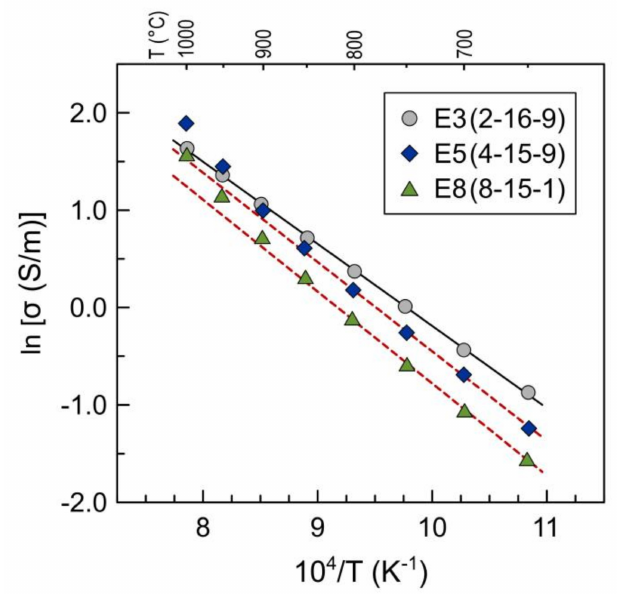
Figure 9. Temperature dependence of electrical conductivity of samples E3 (2-16-9), E5 (4-15-9) and E8